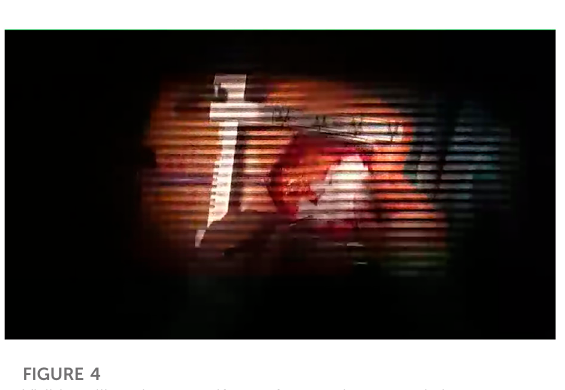
FIGURE 4 Visible rolling shutter artifacts of correctly exposed situs.